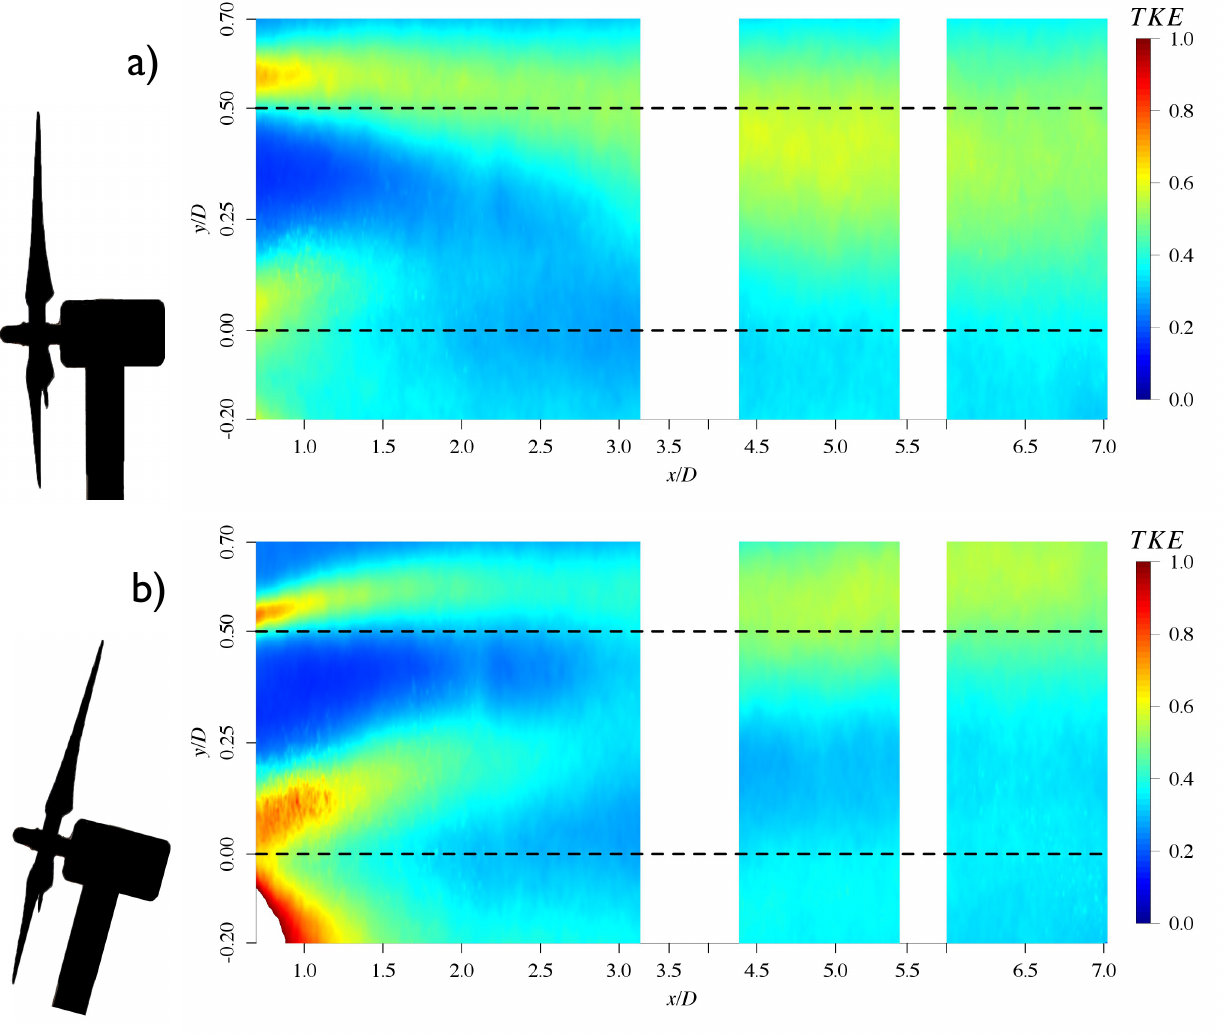
Figure 16. Contours of turbulent kinetic energy T KE = 1 ( b ) floating case. The shapes develop analog to uu/U 2 tip ( y/D = 0.5) are indicated by dashed horizontal